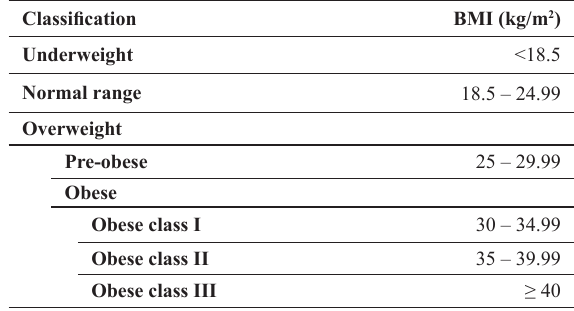
table 1: The International Classification of adult underweight, overweight and obesity according to BMI 7 .